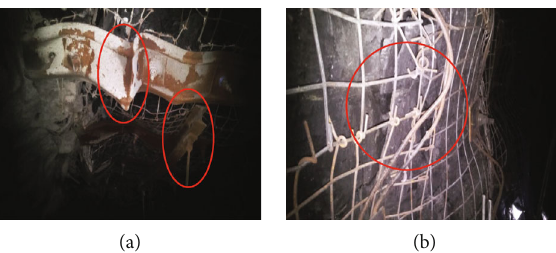
Figure 3: The failure of bolt-cable-mesh support: (a) steel belt bending and shear of anchor cable. (a) Failure of anchor